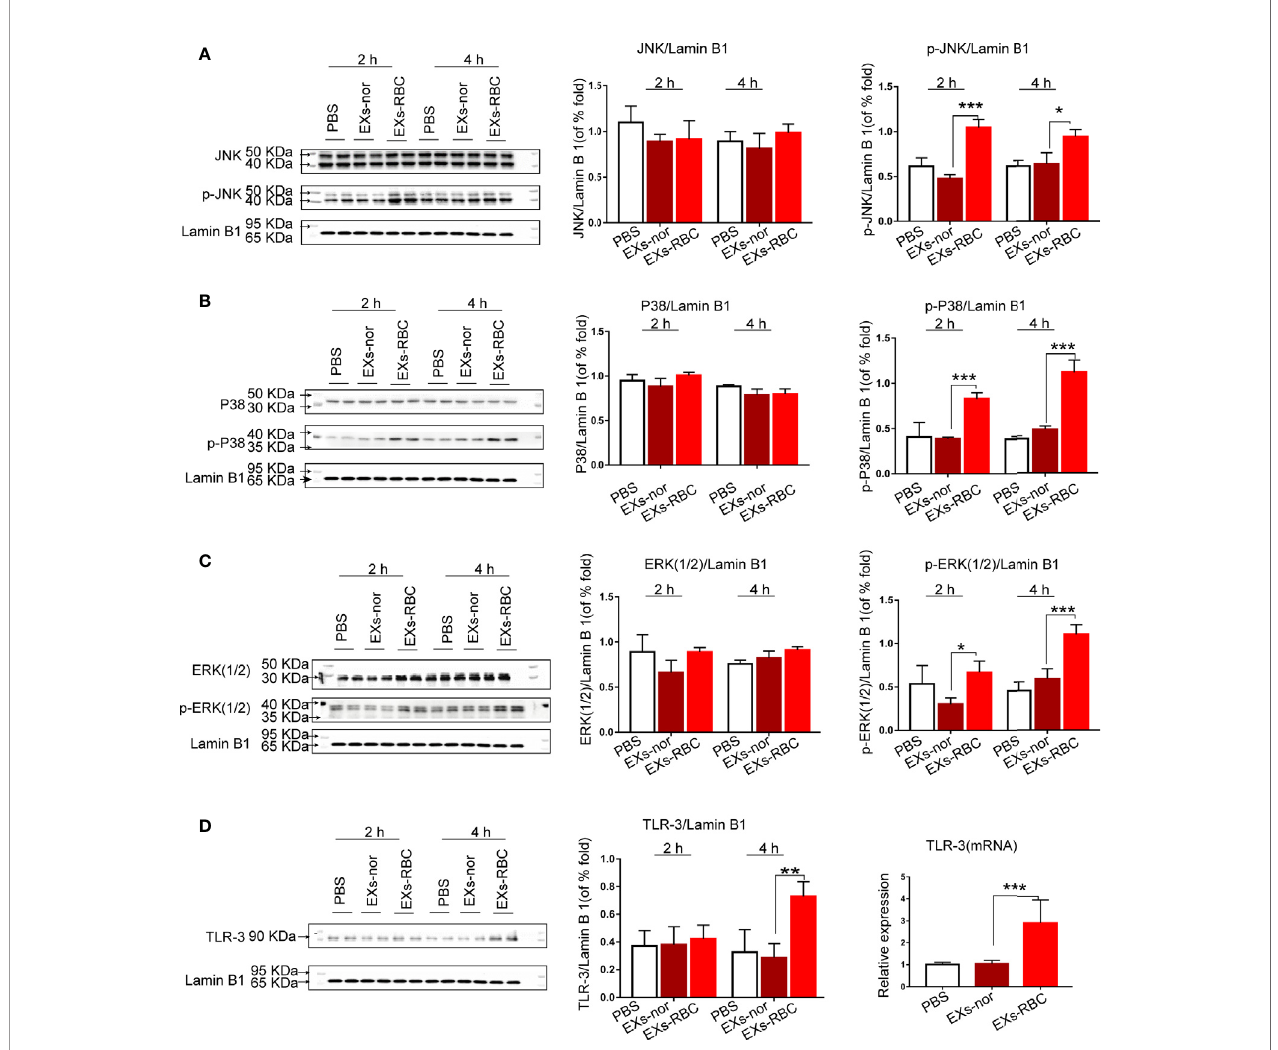
FIGURE 5 | Expression of MAPK pathway and TLR-3 in HMC-1 cells after incubation with PBS, EXs-nor, and EXs-RBC. Cells were collected at 2 h and 4 h. Blots were standardized to lamin B1 expression. Each experiment was employed at least twice. ANOVA and multiple comparisons were performed to compare the differences among groups. * means a statistical difference between two groups (*P < 0.05; **P < 0.01; ***P < 0.001). The left panels are the representative pictures of western blotting, and the right and middle panels are the quantitation of western blotting using Image J software. (A) Expression of JNK and phospho-JNK. (B) Expression of P38 and phospho-P38. (C) Expression of ERK1/2 and phospho-ERK1/2. (D) Right panels: cells were collected at 2 h. TLR-3 mRNA was measured by qPCR. 18S was used for standardization. Left and middle panels: cells were collected at 2 h and 4 h. Blots are standardized to lamin B1 expression. The left panels are the representative pictures of western blotting, and the middle panels are the quantization of western blotting using Image J software. p-JNK, phospho-JNK; p-P38, phospho-P38; p-ERK1/2, phospho-ERK1/2; EXs-nor, exosomes from normal volunteer plasma; EXs-RBC, exosomes from red cell